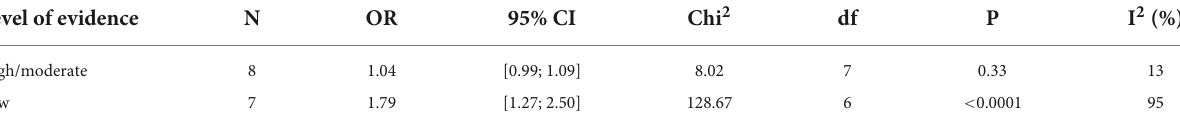
TABLE 2 Odds ratio and heterogeneity by level of evidence. Level of